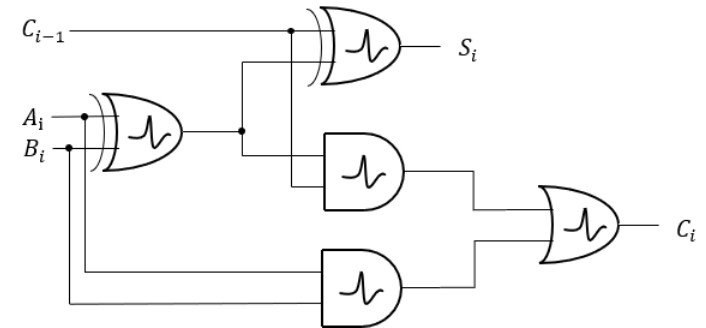
Figure 13. The network structure of the full